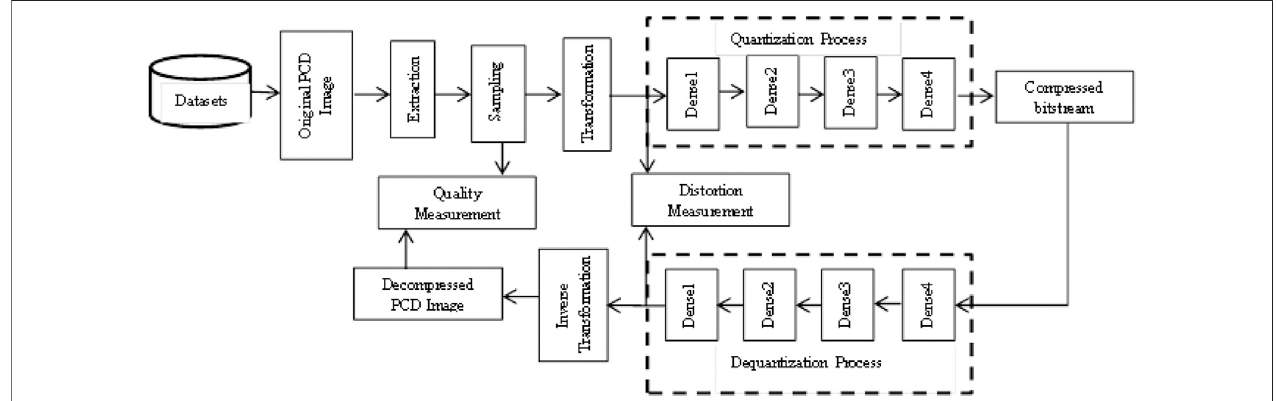
FIGURE 1 | The architecture of the proposed DLQCPCD